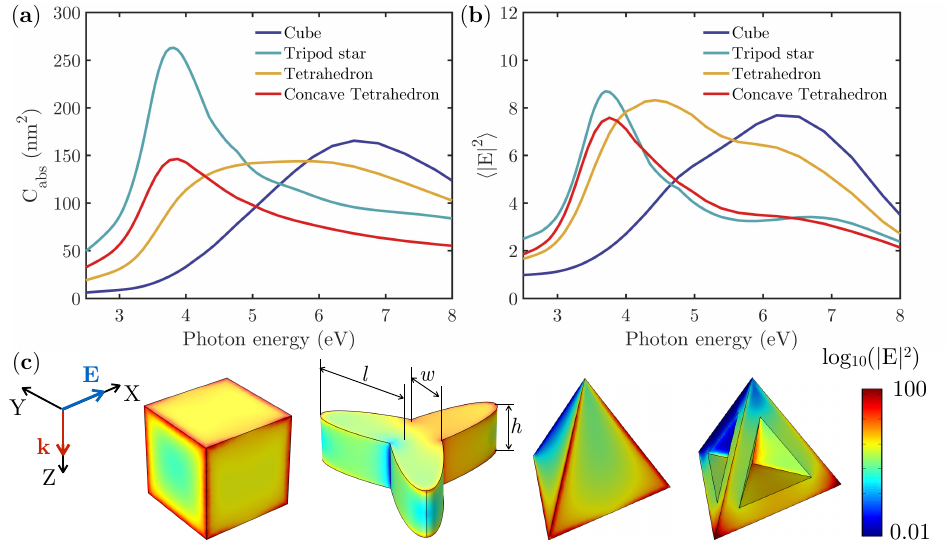
2 ) of a cube E | | 2 ) over the surface of the E | |